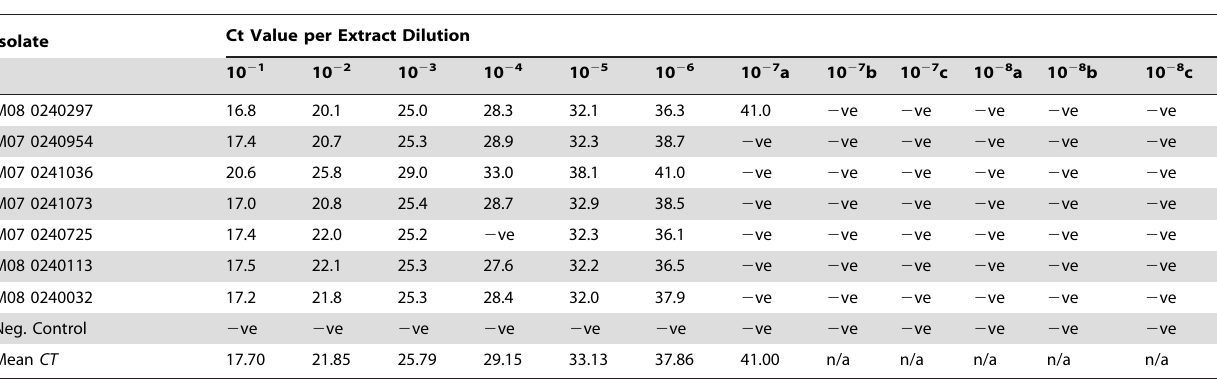
Table 4. Ct values generated using real-time TaqMan PCR